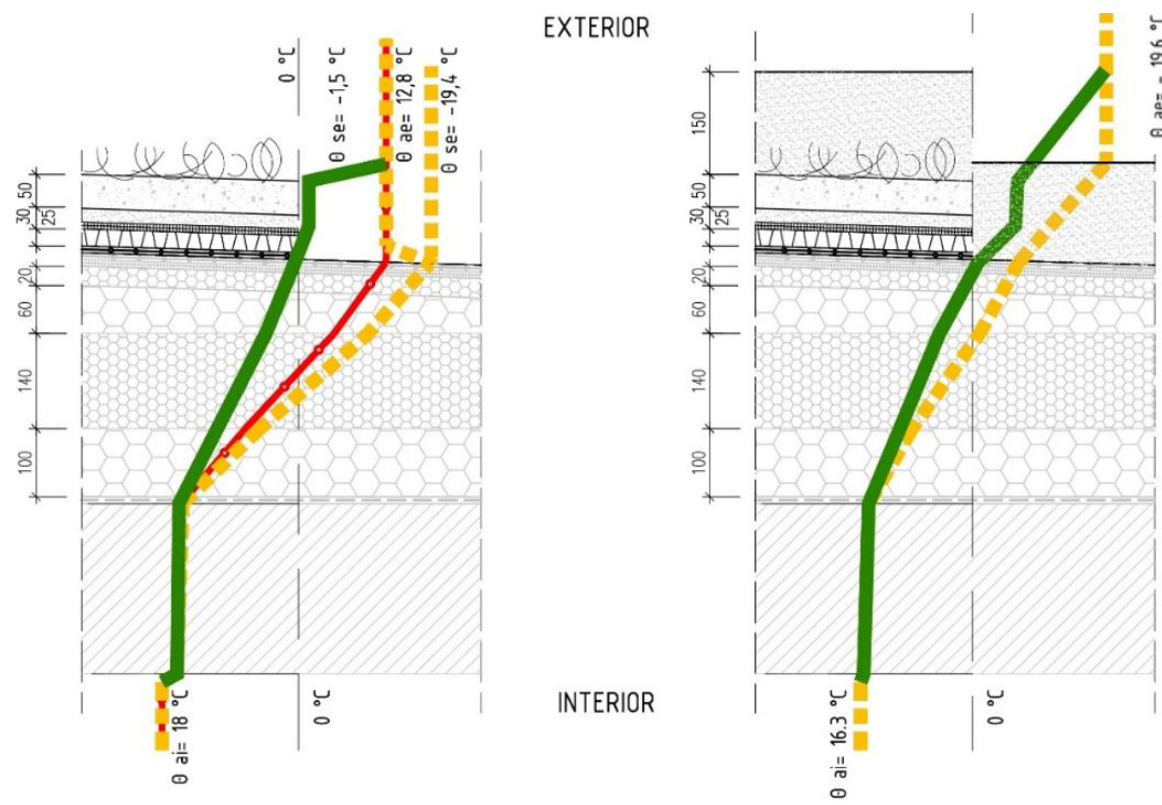
Figure 8. Steady state calculations of temperature courses within the roof not covered by snow (left) and with snow (right).